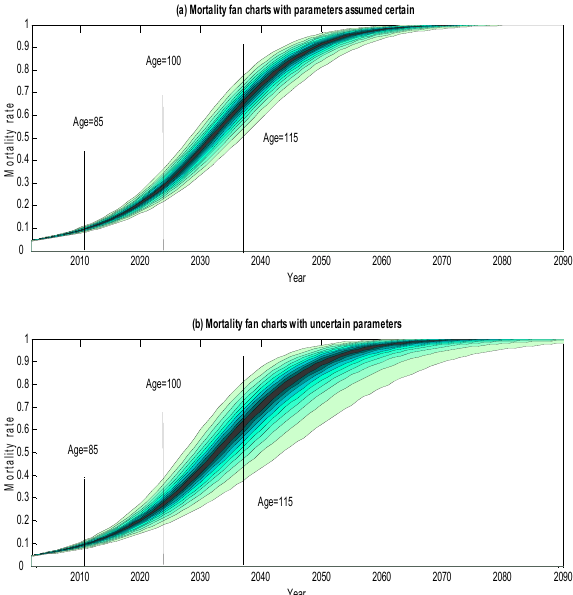
Figure 2. Mortality Fan Charts for Cohorts of Males Currently Aged 75 Years Old. Notes: As per Figure 1.